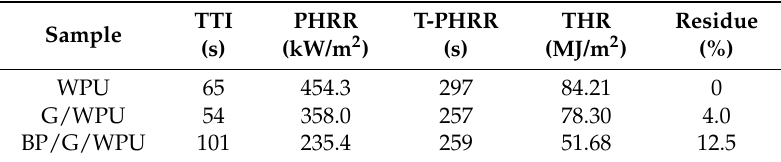
Figure 10. Cone calorimeter test of PLA composites at the concentration of 10 wt%: ( a ) HRR curves; ( b ) THR curves; ( c ) CO release curves; ( d ) CO 2 release curves. Table 2. The CC data of WPU, G/WPU, and BP/G/WPU.